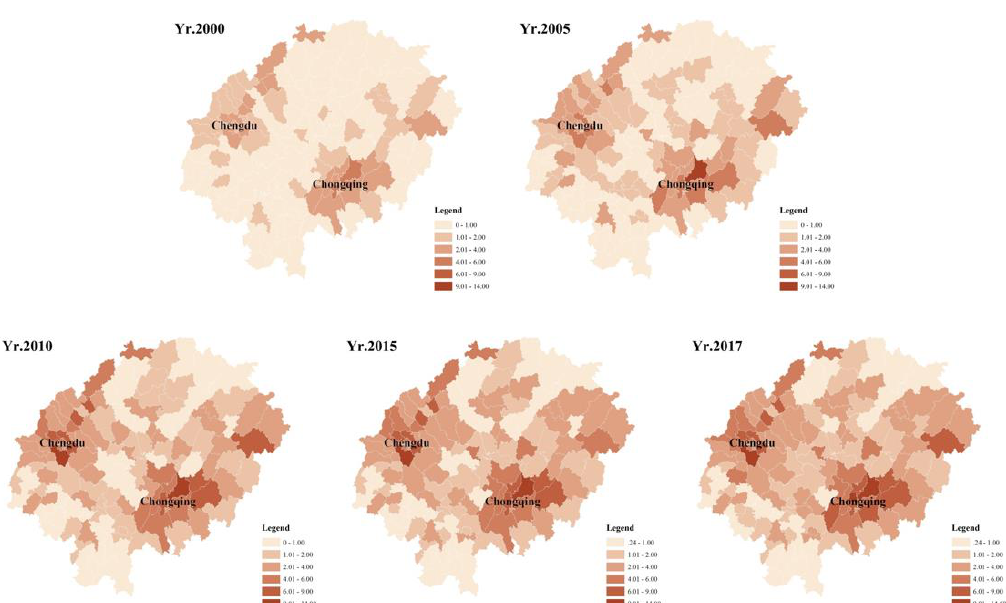
Figure 3. Carbon emission Violin Plot: 2000−2017.